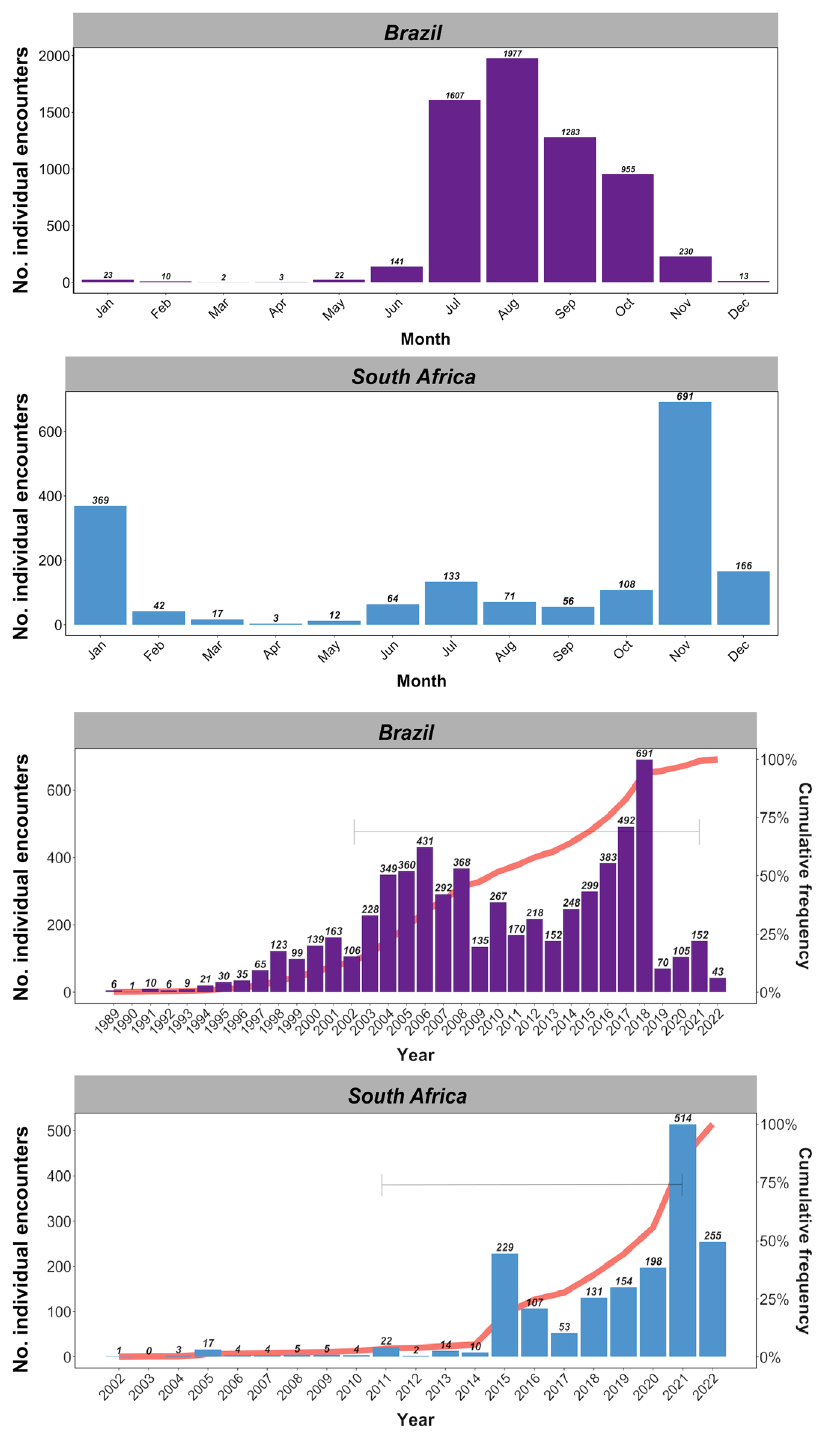
Figure 2. Bar charts showing the number of individual encounters of Southern Hemisphere humpback whales photographed by month and by year off the Atlantic coast of Brazil from 1989 to 2022 and off the Western and Eastern Capes of South Africa from 2002 to 2022. The horizontal gray bars in the yearly bar charts show the timespan between photo-ID recaptures of humpback whales in each region. The red line shows the cumulative frequency or ‘discovery curve’ of identified individuals. The graph was made in R statistical software 56 using the package ggplot2 57